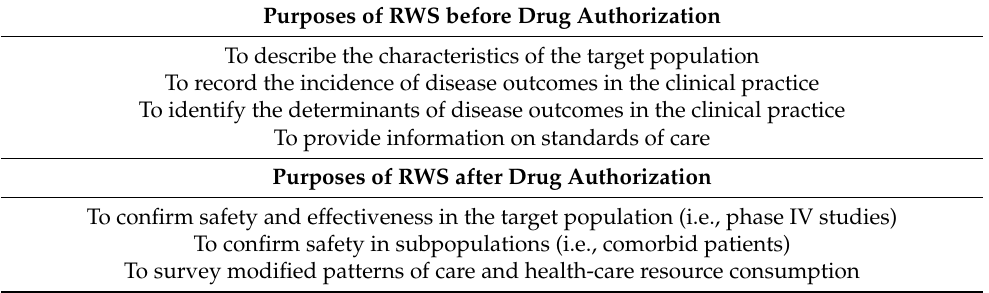
Table 1. Aims of real-world studies